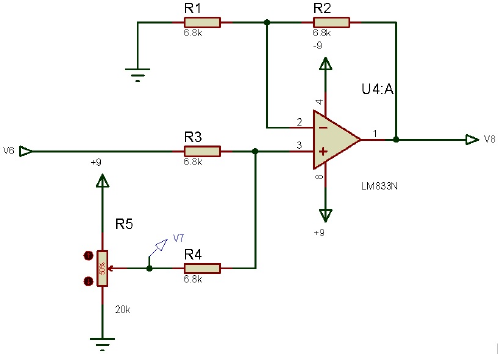
Figure 8. Designed offset